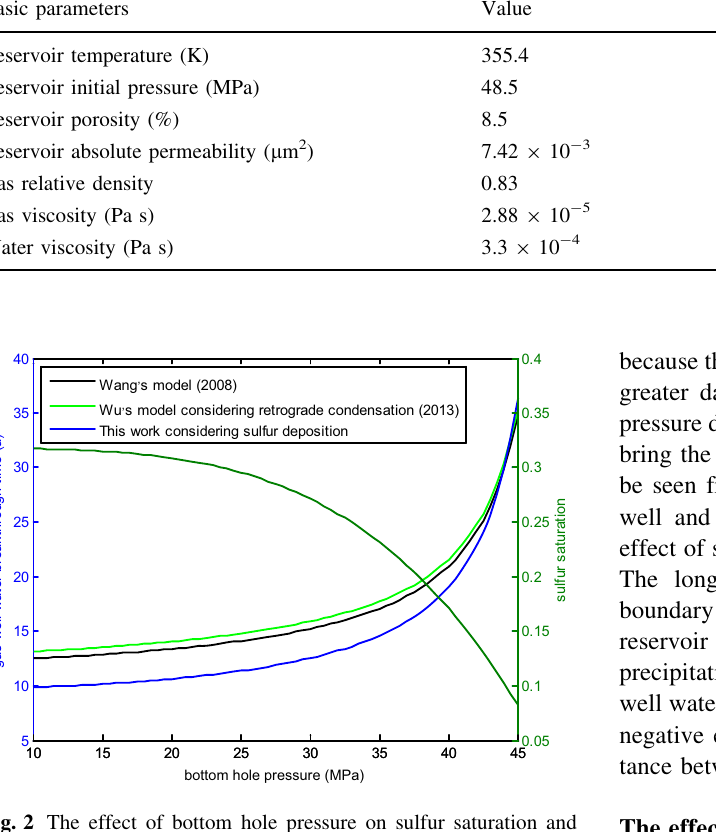
Fig. 2 The effect of bottom hole pressure on sulfur saturation and water breakthrough time